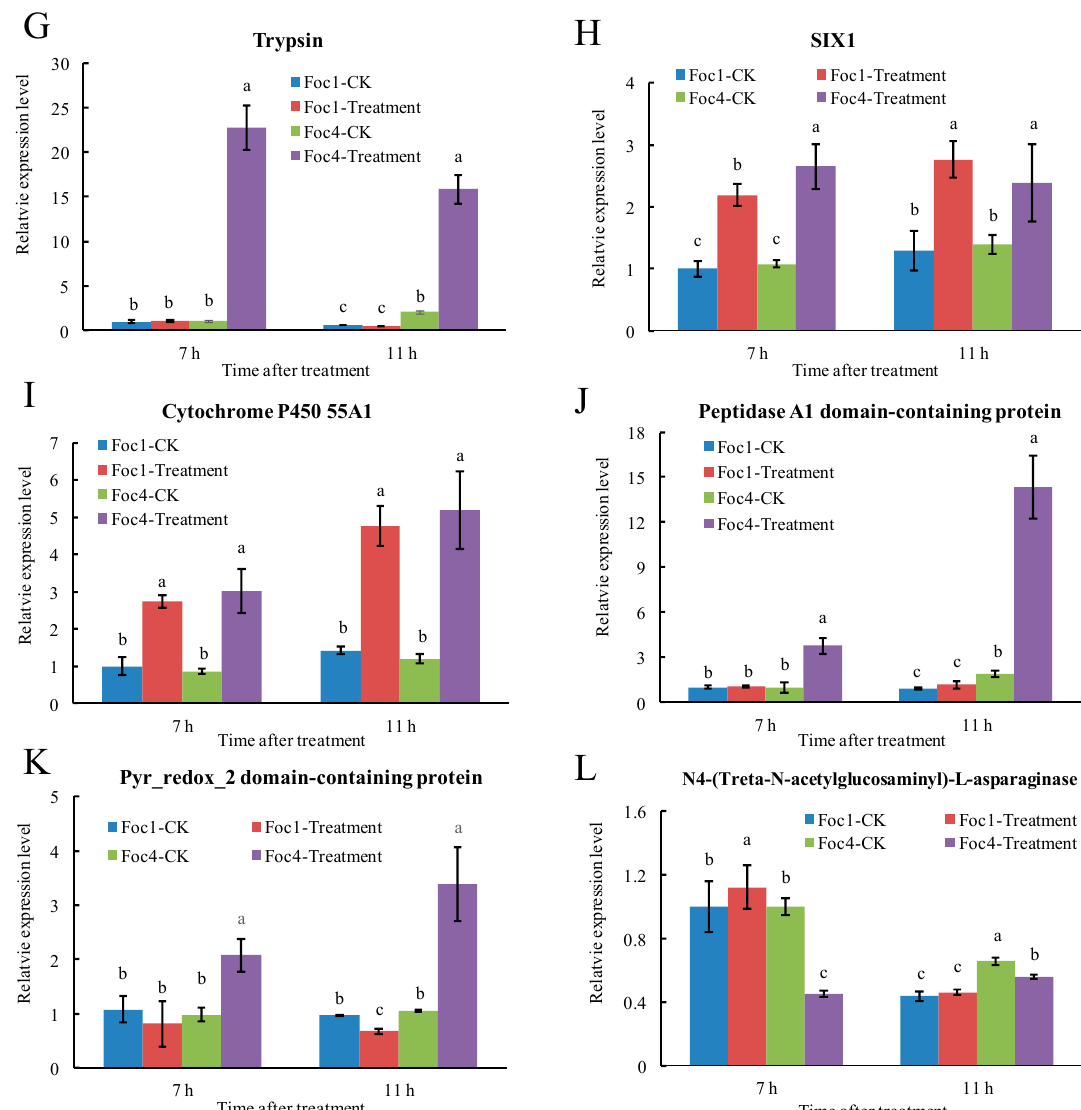
Figure 5. Expression analysis by RT-qPCR of 12 secreted protein genes after banana plant extracts treatment. ( A ): cutinase; ( B ): glycosyl hydrolase family 17; ( C ): endopolygalacturonase; ( D ): polygalacturonase; ( E ): endo-1,3(4)-Treta-glucanase; ( F ): alpha 1,3-glucosidase; ( G ): trypsin; ( H ): SIX1; ( I ): cytochrome P450 55A1; ( J ): peptidase A1 domain-containing protein; ( K ): Pyr_redox_2 domain-containing protein; ( L ): N4-(Treta-N-acetylglucosaminyl)-L-asparaginase. Values are the means (±SE) based on three independent experiments, and bars indicate standard deviations. Different small letters in each group indicate significant differences at p ≤ 0.05.